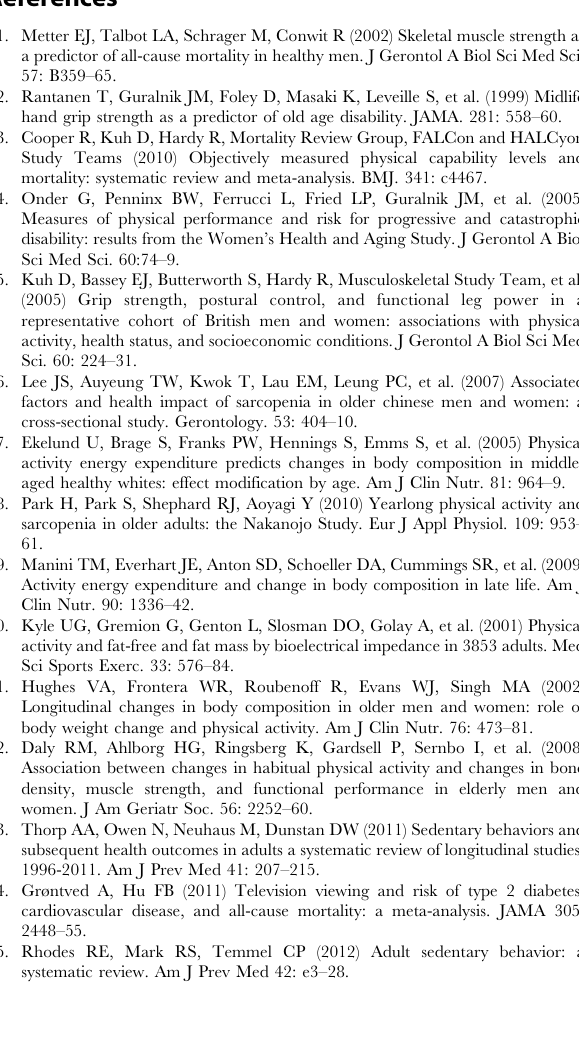
Figure S2 Scatter plot of TV viewing against grip strength (upper panel) and chair rises time (lower panel). Table S1 The association between covariables and muscle strength in men (N = 2845).